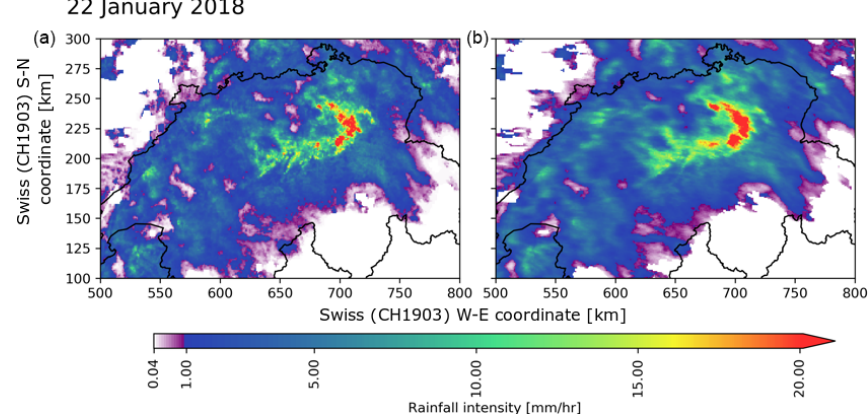
Figure 13. Resulting QPE field on a case of widespread snowfall, on the left with Gaussian smoothing ( σ = 0 . 5 pixels) and on the right with advection